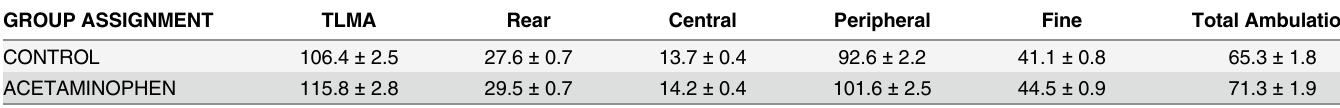
Table 2. Mean values of different activities according to group assignment.